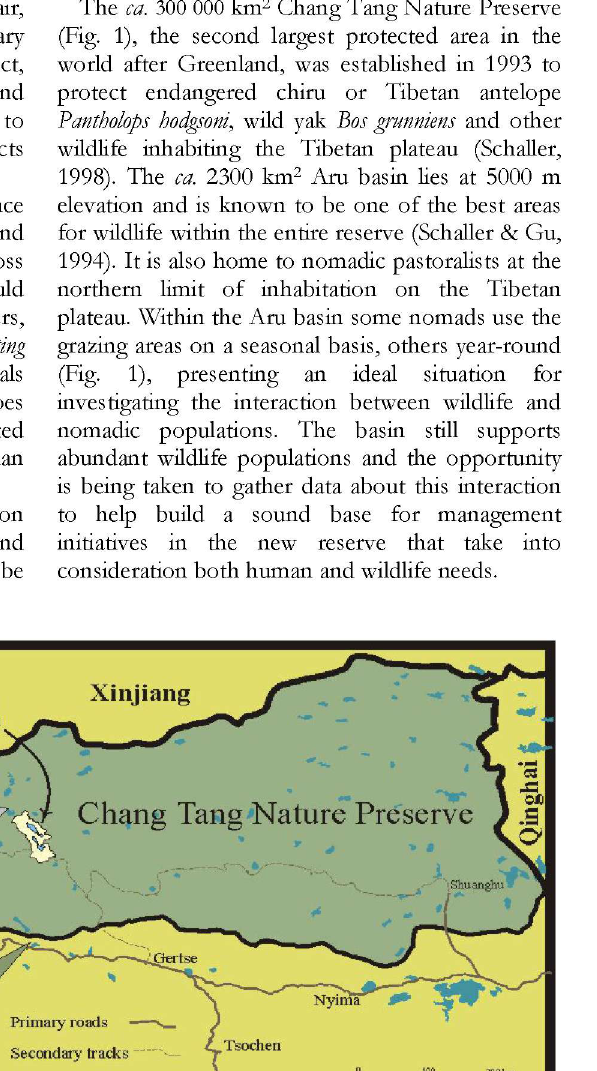
Fig. 1. The ca 2300 km 2 Aru basin study area within the ca. 300 000 km 2 Chang Tang Nature Preserve. The basin's grazing areas are divided between two administrative districts: a) the Gertse Xian portion has no distinct seasonal grazing pattern, several permanently resident families, and additional seasonal use by herders based outside of the basin, whereas b) the Rutok Xian grazing zone has distinct seasonal areas. Only Rutok herders from outside the basin use the summer grazing area below the dotted